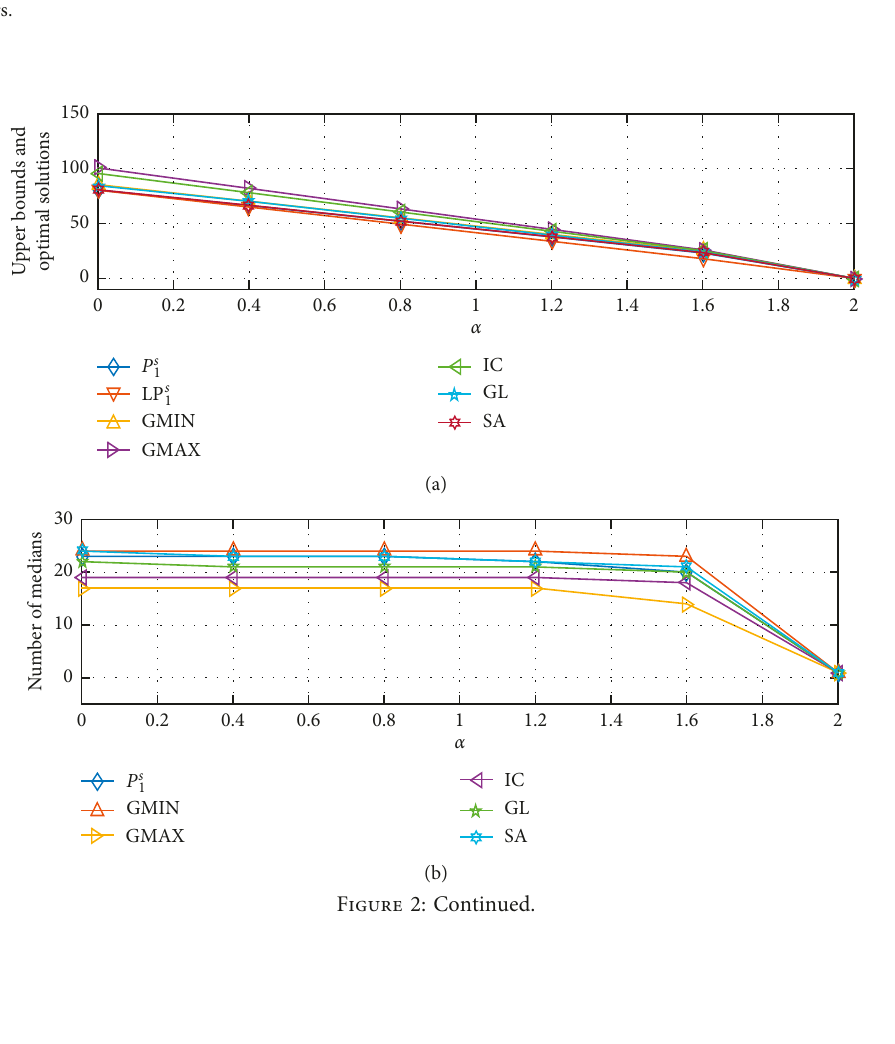
Table 11: Maximal cliques and maximal independent sets obtained with the Bron–Kerbosch algorithm for the instances #1–#15 in Table 9 using a radial coverage value of 0.5km. Instance number 1 # Maximal C. - - Maximum C. 128 # Maximal I.S. - - - - - - - Maximum I.S. -, not solved in 2